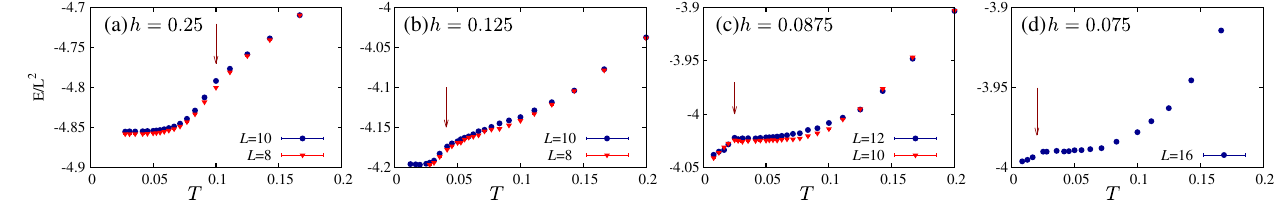
FIG. 8. Energy as a function of temperature for the N ¼ 2 model at various values of h